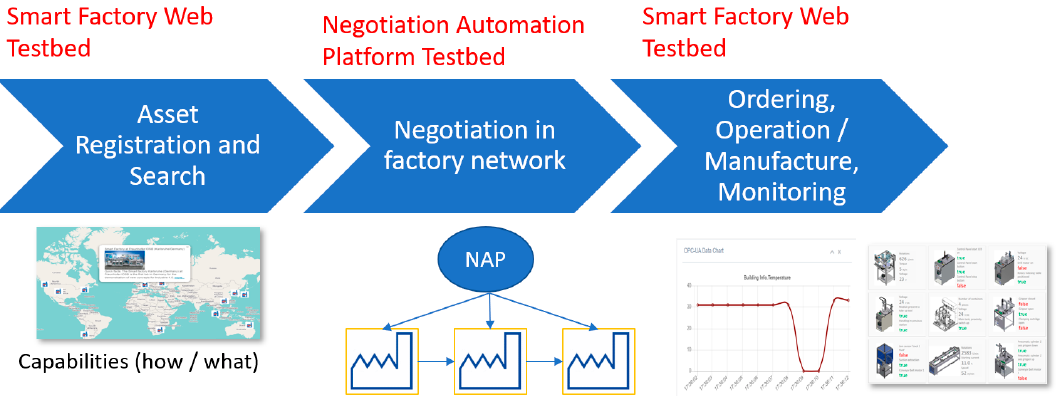
Figure 2. Smart Factory Web workflow in three steps.